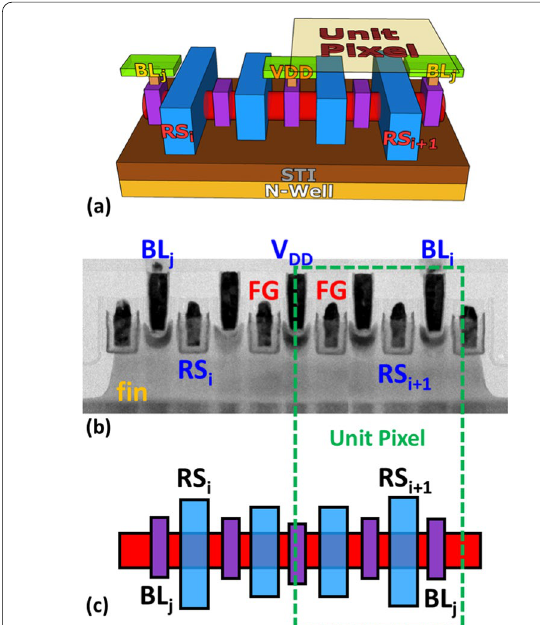
Fig. 2 a The 3D structure, b TEM image along BL and c layout illustration of the proposed e‑beam detector, featuring compact